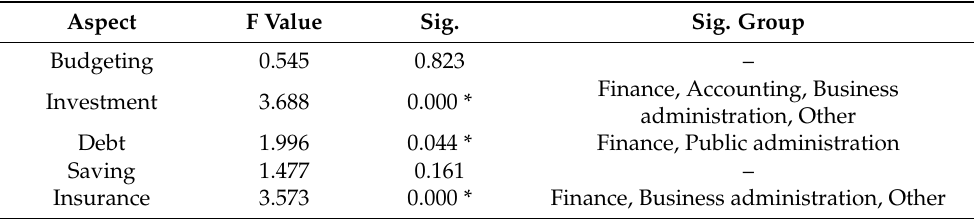
Table 14. Differences according to major using the ANOVA test ( n = 887). Aspect